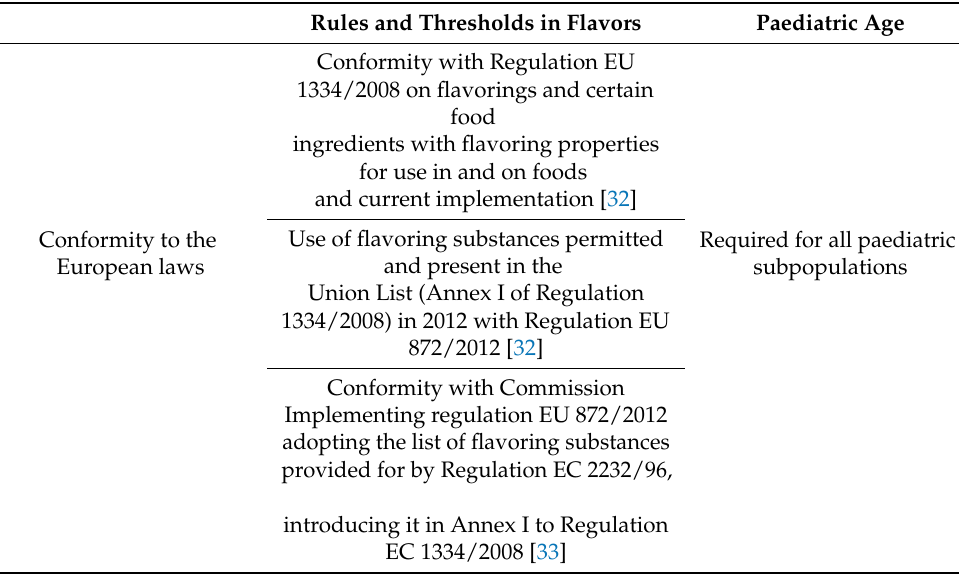
Table 2. Regulatory aspects concerning the safety of